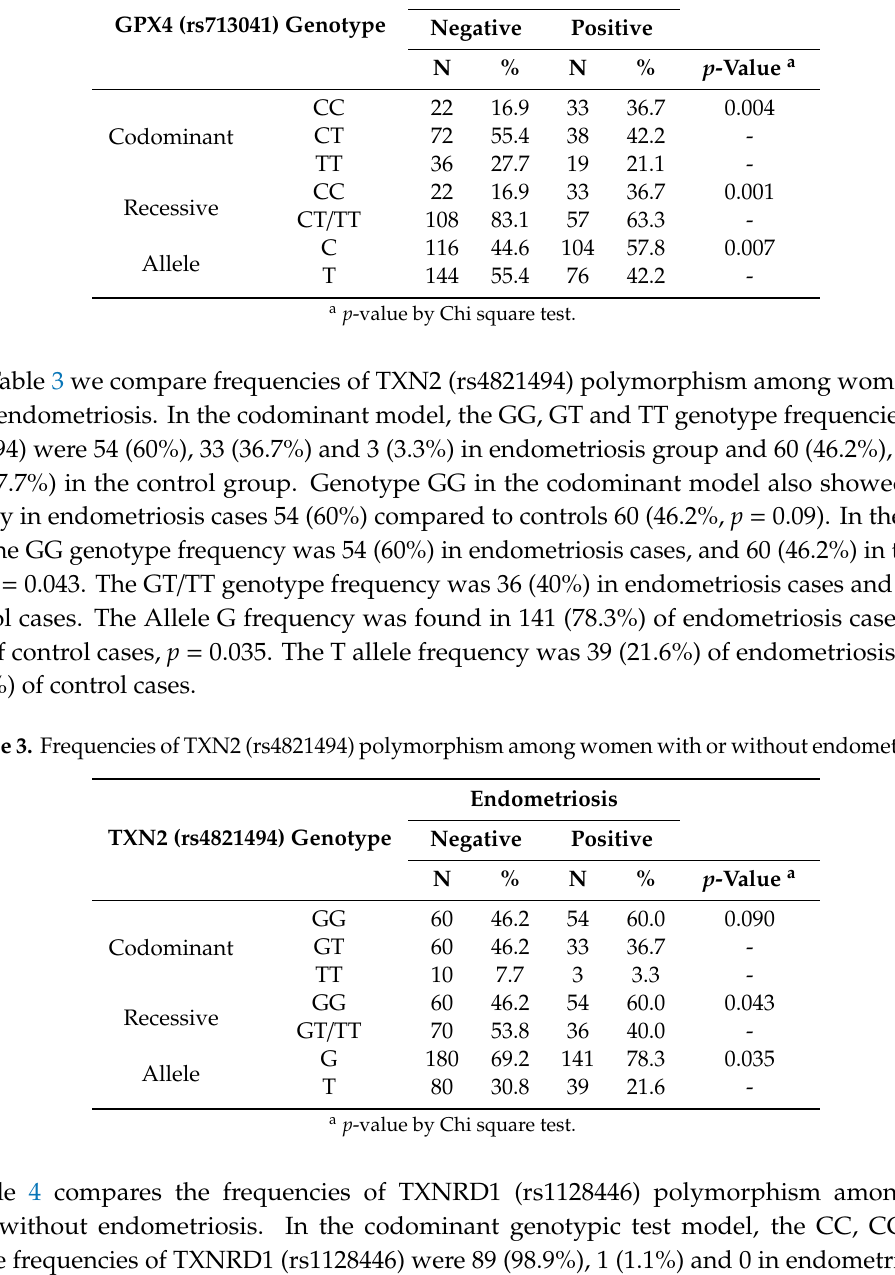
GPX4 (rs713041) Genotype